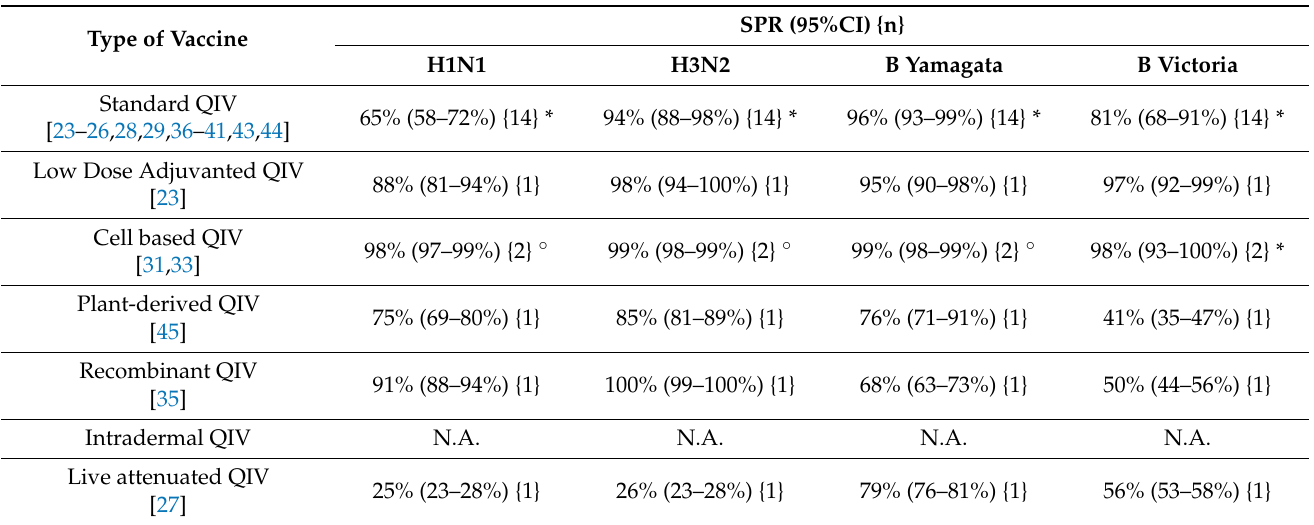
Table 2. Type of vaccine and seroprotection rate (SPR) for the four strains A/H1N1, A/H3N2, B/Yamagata and B/Victoria {Number of